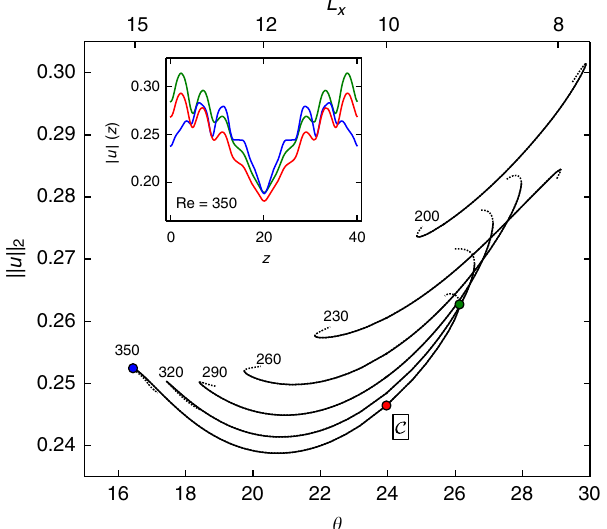
Fig. 6 Range of pattern orientation angle θ for which the stripe equilibrium C exists. Parametric continuations in θ at constant L z = 40 implying L x ~ tan − 1 ( θ ) (top axis). The solution branches are labeled by Re , which remains fi xed for each continuation. Beyond saddle-node bifurcations only the initial part of the branches are plotted (dotted lines). Along the remaining parts of the branches (not shown), the equilibrium solutions no longer represent the stripe pattern. The inset displays the amplitude pro fi les at selected points along the branch (like in Fig. 4). For θ increasing towards the upper saddle- node the amplitude of the pro fi le | u |( z ) rises globally at all z ; for θ decreasing towards the lower saddle-node the amplitude maximum decreases. At intermediate angles close to θ = 24° the equilibrium best represents turbulent-laminar